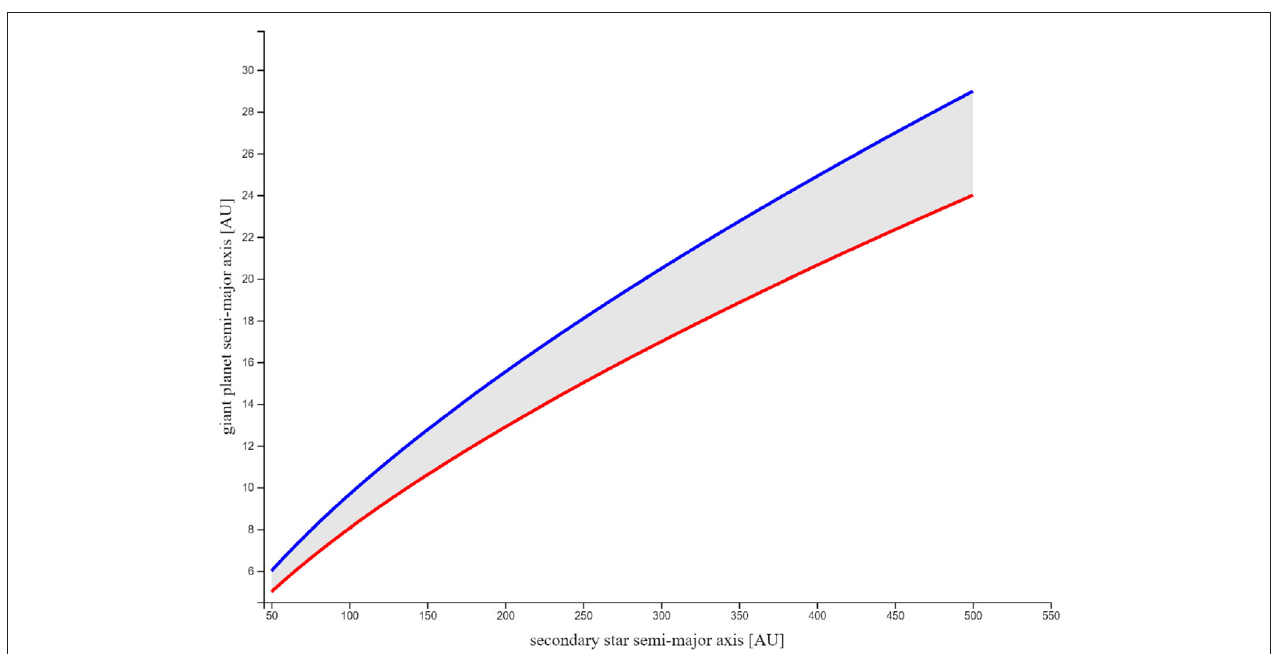
FIGURE 3 | Result of the online-tool SHaDoS for the binary system HD106515AB. The gray stripe shows which combinations may lead to an SR in the primary star’s HZ for the defined semi-major axis range of the secondary star (x-axis) and the giant planet (y-axis).